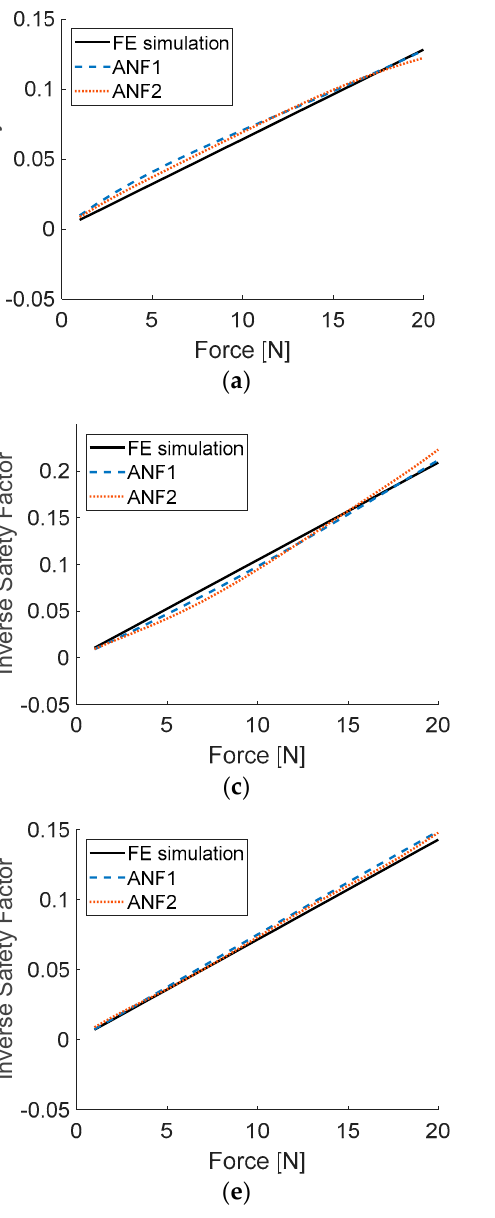
Table 2. Comparison of accuracy and computational time for obtained ANFIS models.